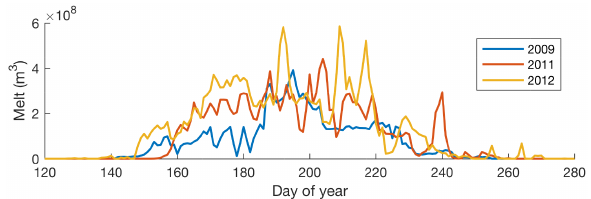
Figure 2. Daily surface runoff over the SRLF Russell Glacier study area for three contrasting summer melt